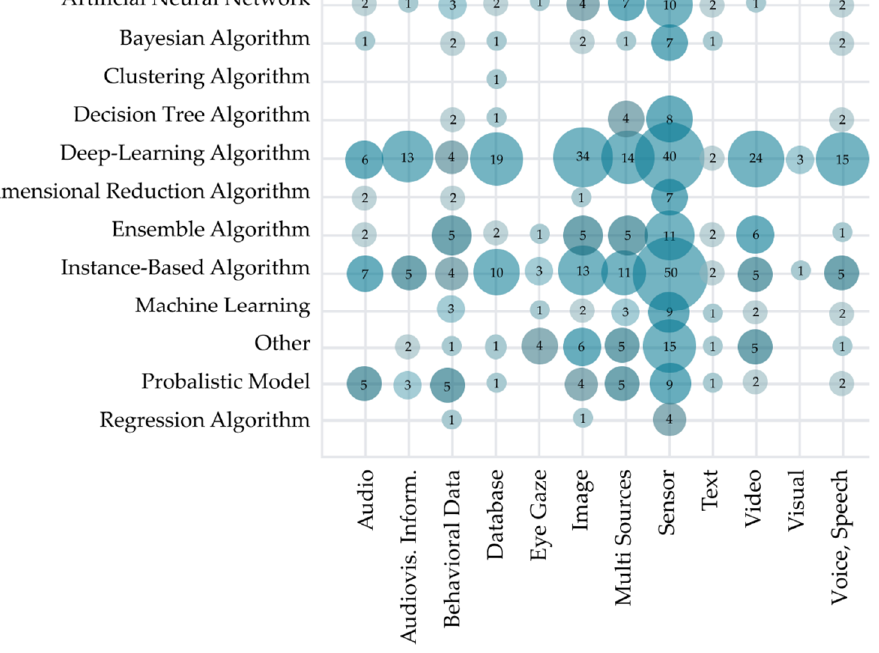
Figure 18. Distribution of data sources used in AI methods and algorithms.